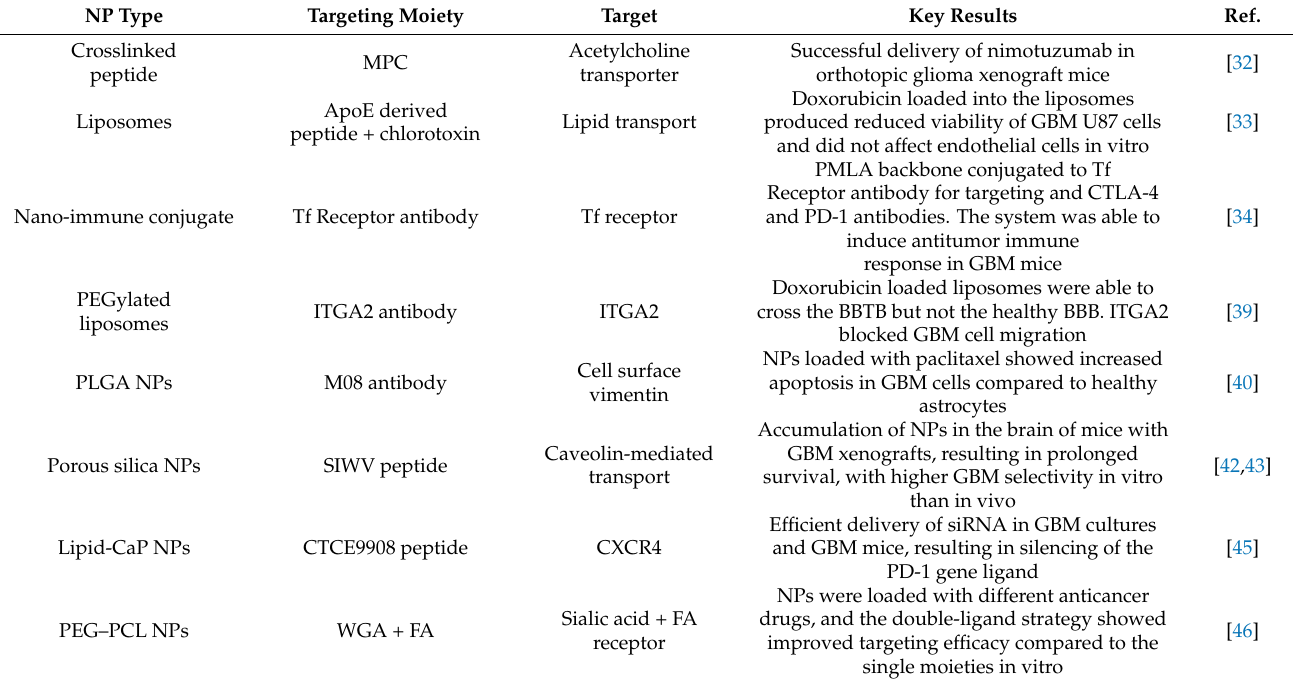
Table 1. Summary of the presented nanosystems for GBM targeting.